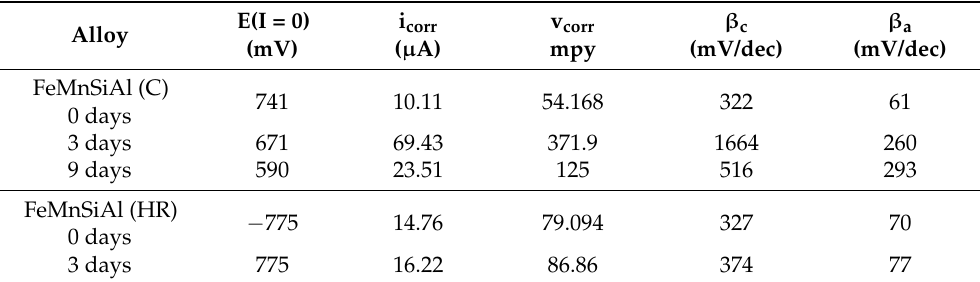
Table 6. Linear (Tafel) potentiometry parameters in Ringer solution (three electrodes